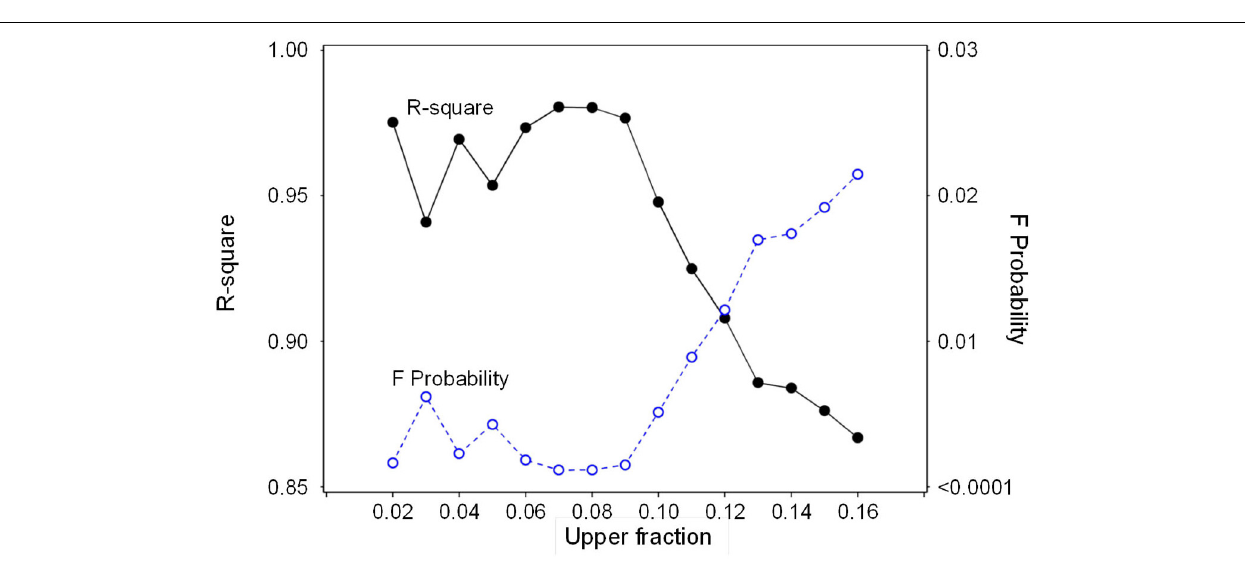
FIGURE 3 | Regression statistics (R-square and F Probability) for the relation between average SWP and average VPD (as in Figure 2 ) for a range of upper fractions of SWP